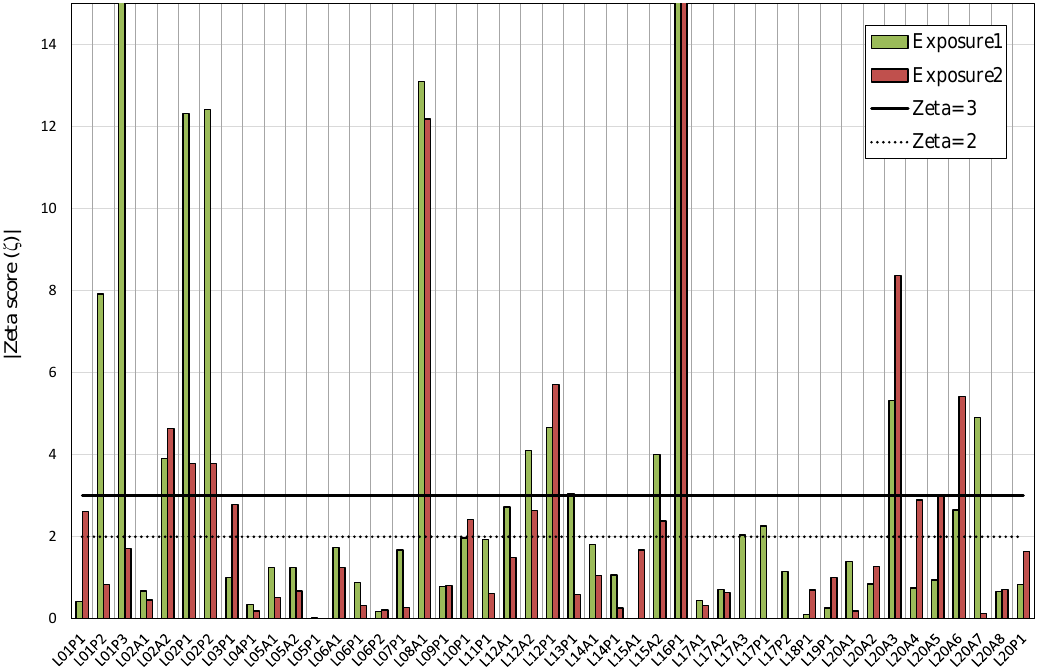
Figure 8. Absolute values of Zeta score for the first and second exposure.